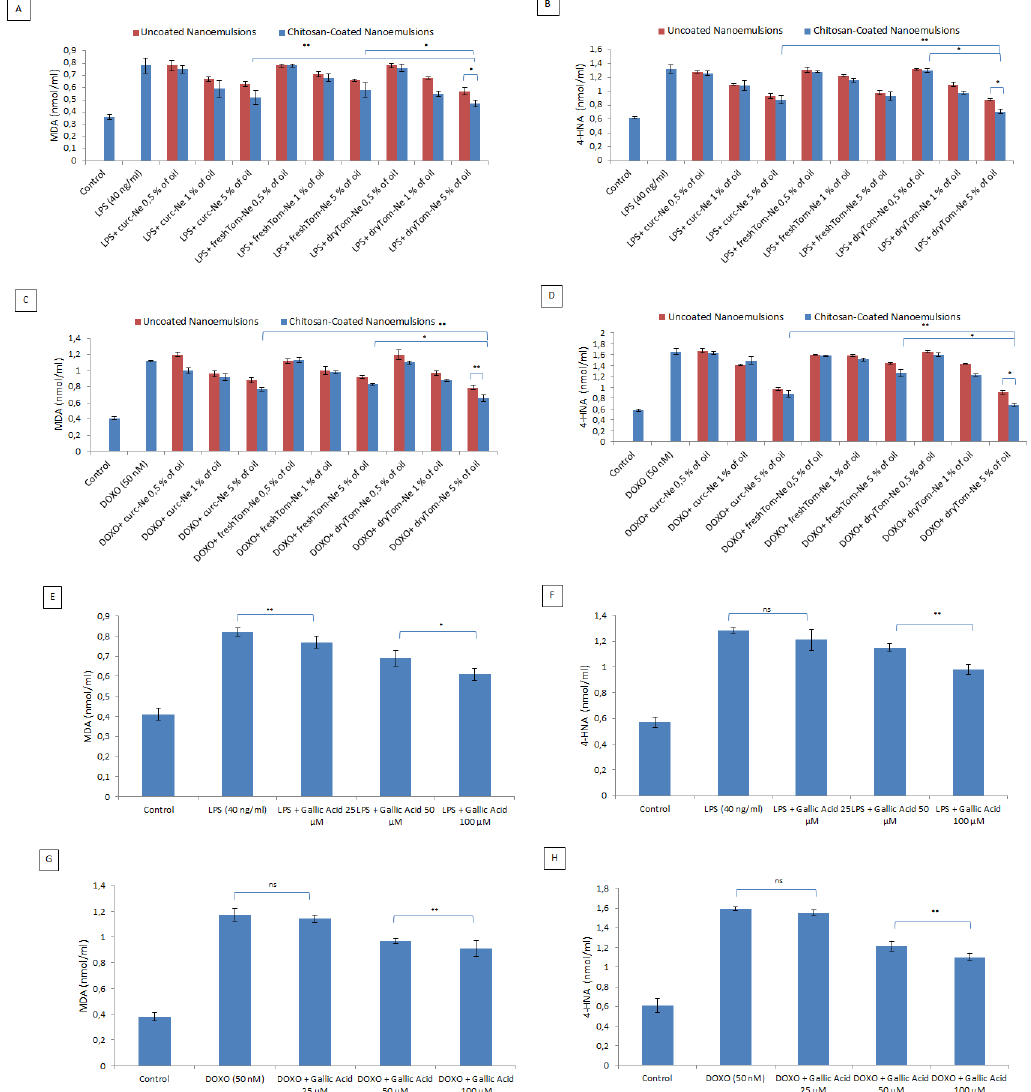
Figure 7. Cellular quantification of malondialdehyde (MDA) and 4HNA production under pro-inflammatory conditions and doxorubicin exposure. MDA and 4HNA (nmol/mL) production by cardiomyoblasts treated with LPS ( A , B ) and doxorubicin ( C , D ) alone or combined with uncoated or chitosan-coated nutraceutical-loaded nanocarriers at concentrations ranging from 0.5 to 5% oil. At the same condition, as positive control, we tested also the effects of gallic acid at 25, 50 and 100 µM ( E , F ) for LPS treatments; ( G , H ) for doxorubicin treatments). * p < 0.001; ** p < 0.05; ns: not significant.